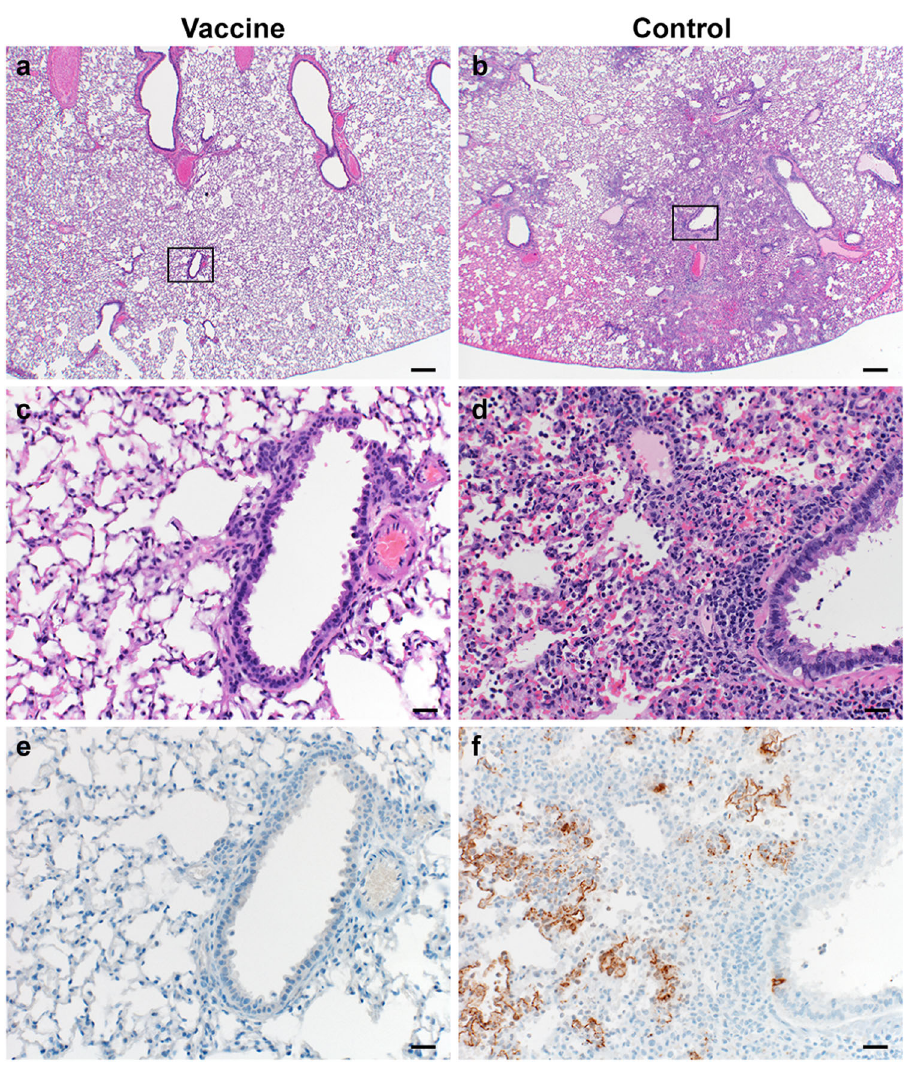
Fig. 3 Pulmonary effects of direct intranasal challenge with SARS-CoV-2 variant B.1.1.7 in Syrian hamsters at 5 DPI. a , b H&E staining, 20x, scale bar = 200 µ m; a no pathology. b Focally extensive areas of bronchointerstitial pneumonia. c , d H&E staining, 200x, scale bar = 20 µ m; c no pathology. d Bronchointerstitial pneumonia with alveolar histiocytosis, fi brin and edema. e , f IHC staining against N protein SARS-CoV-2 (brown) 200x, scale bar = 20 µ m. e No staining. f Staining of bronchiolar epithelial cells, type I&II pneumocytes, and rare macrophages. Micrographs are representative of what was observed viewing 100% of a single 5 µ m section of the complete lungs containing all lobes for each of four